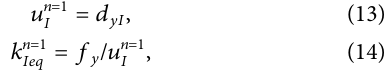
Frontiers in Built Environment |